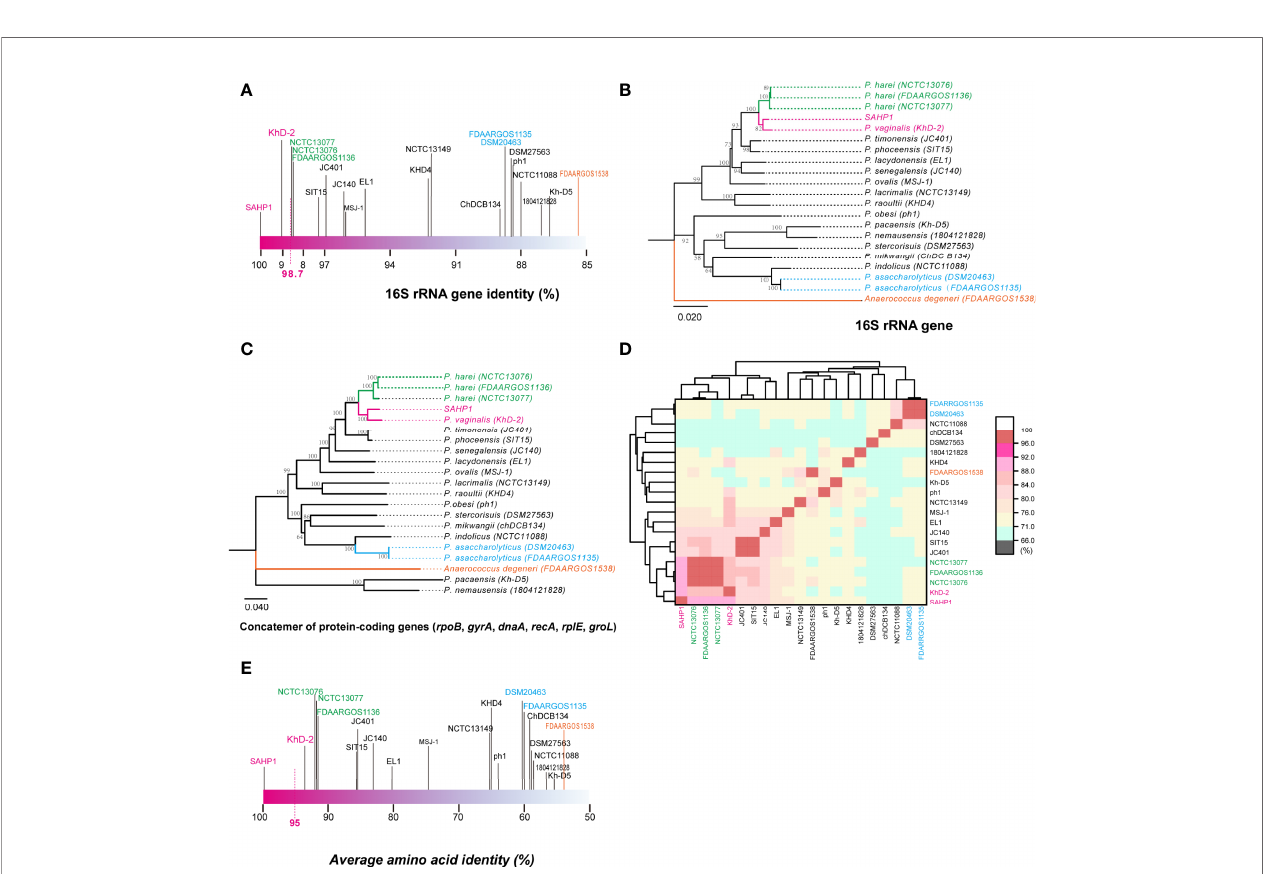
FIGURE 4 | The 16S rRNA gene identity analysis and phylogenetic, ANI, and AAI analyses of SAHP1 with other reference strains in the genus Peptoniphilus . (A) The 16S rRNA gene identities between SAHP1 and other reference strains of the genus Peptoniphilus. Magenta indicates the highest identity of the 16S rRNA gene with SAHP1. Green indicates P. harei strains, while blue indicates P. asaccharolyticus strains, and orange indicates the Anaerococcus degeneri strain that belongs to the same family, the Peptoniphilaceae , as those Peptoniphilus strains. (B) Phylogenetic analysis of full 16S rRNA. (C) The MLSA-based phylogenetic tree of strain SAHP1 and other Peptoniphilus strains. The tree is based on six housekeeping protein-coding genes. Phylogenetic inference was performed with MEGA X. The bootstrap values of 1,000 replications display the signi fi cance of each branch, and those higher than 50% are shown in the taxa clustered in the tree. The tree is drawn to scale, with branch lengths measuring in the number of substitutions per site. (D) ANI between SAHP1 and different Peptoniphilus strains, and all showed a <92% ANI; the cluster diagram of ANI showed a close relationship among SAHP1 and P. vaginalis KhD-2 and the three P. harei strains. (E) AAI between SAHP1 and other reference strains. Green indicates P. harei strains, while blue indicates P. asaccharolyticus strains, and orange indicates the Anaerococcus degeneri strain that belongs to the same family, the Peptoniphilaceae , as those Peptoniphilus